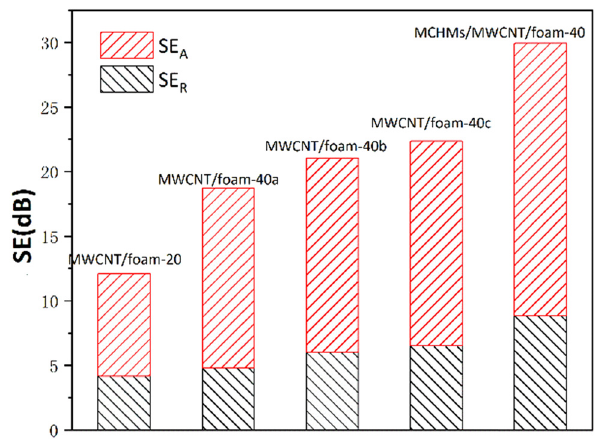
Figure 5: SE R and SE A of MWCNT/foam - 20, MWCNT/foam - 40a, MWCNT/foam - 40b, MWCNT/foam - 40c, and MCHMs/MWCNT/foam - 40 at 9.04 GHz.